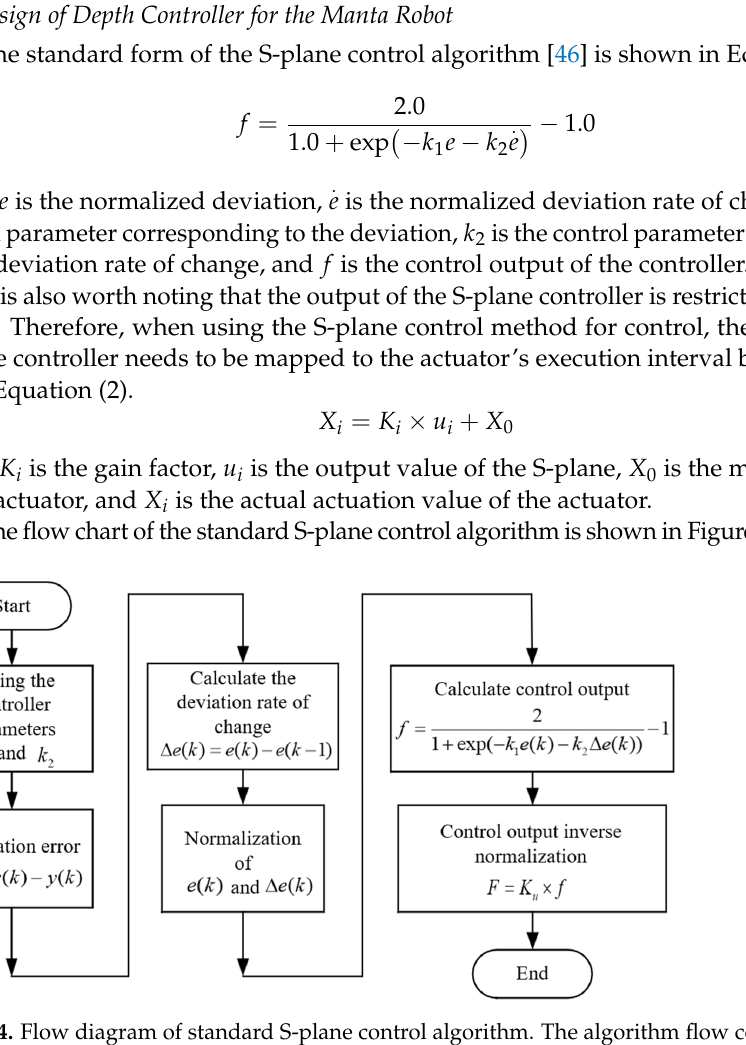
Figure 3. The motion control system of the manta robot consists of two parts: the depth controller and heading controller. The design of both controllers is based on the S-plane.